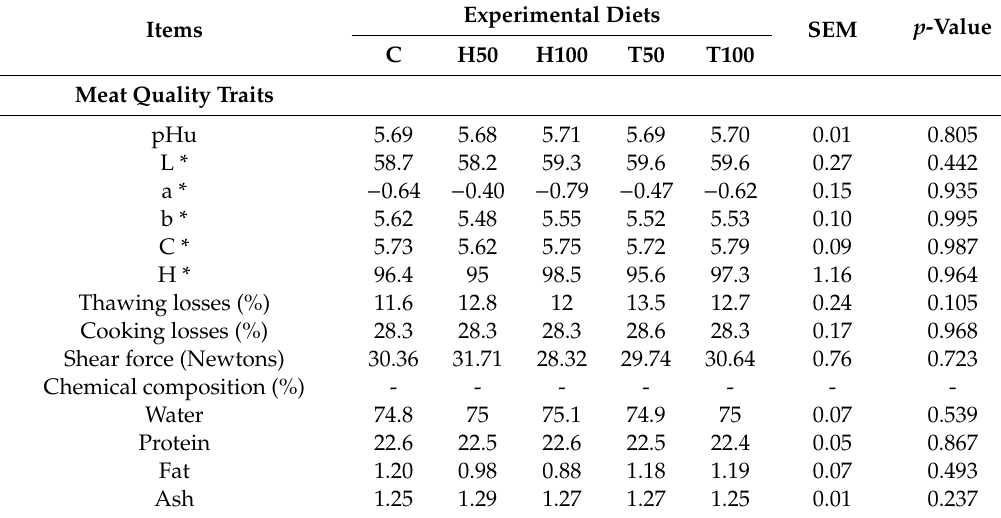
Table 4. E ff ect of the experimental diets on the meat quality traits and chemical composition of Longissimus thoracis et. lumborum of rabbits (n = 15 rabbits /